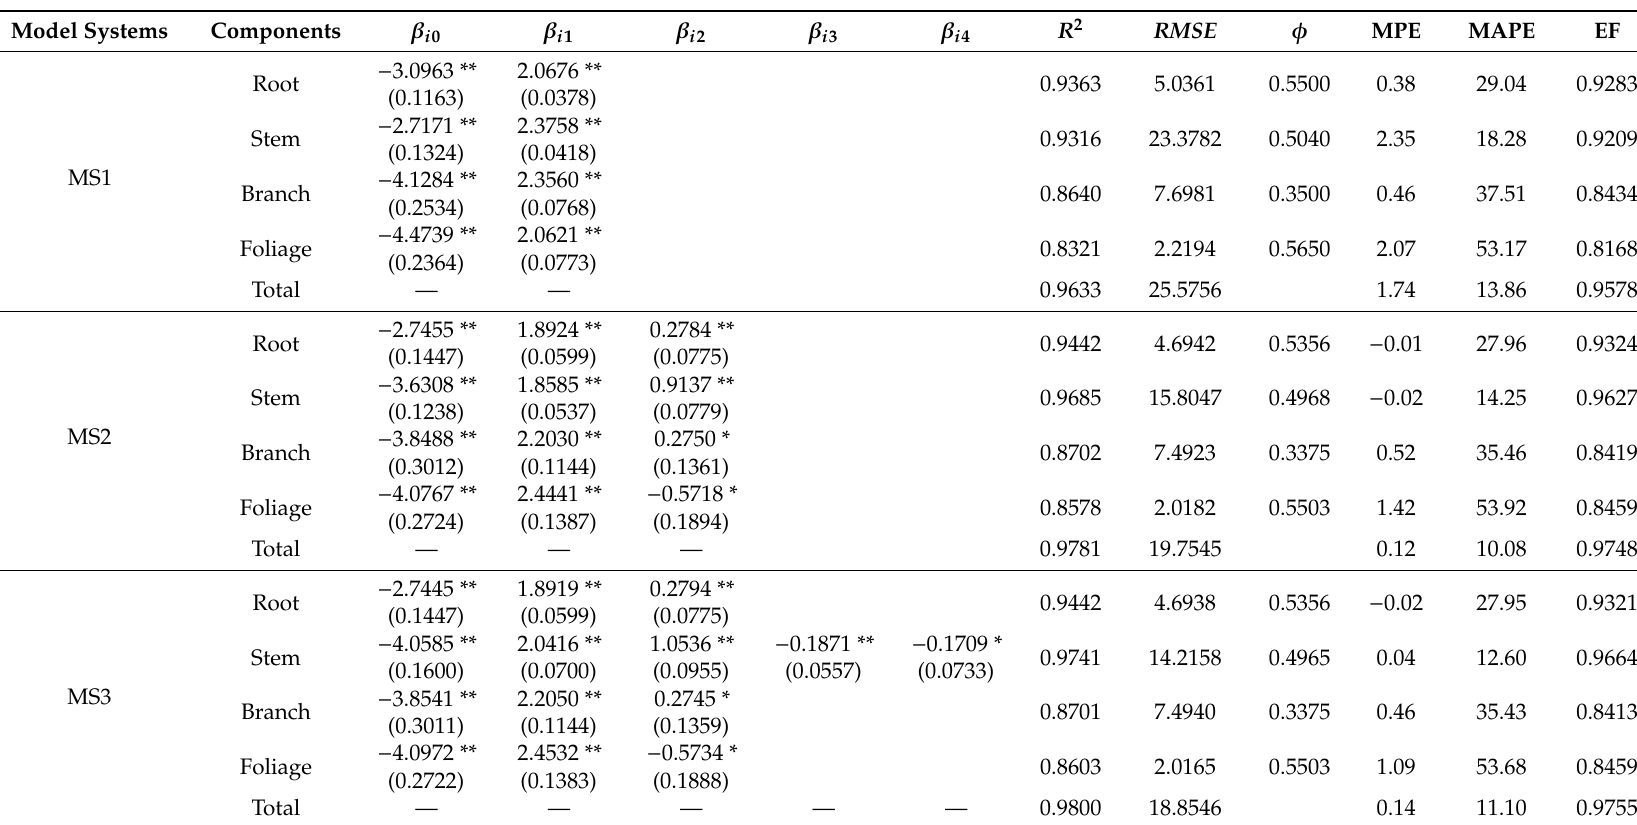
Table 3. Parameter estimates, standard errors (in parenthesis), goodness-of-fit statistics, jackknifing validations, and the parameter of weight functions ( φ ) for three additive biomass model systems based on di ff erent predictor